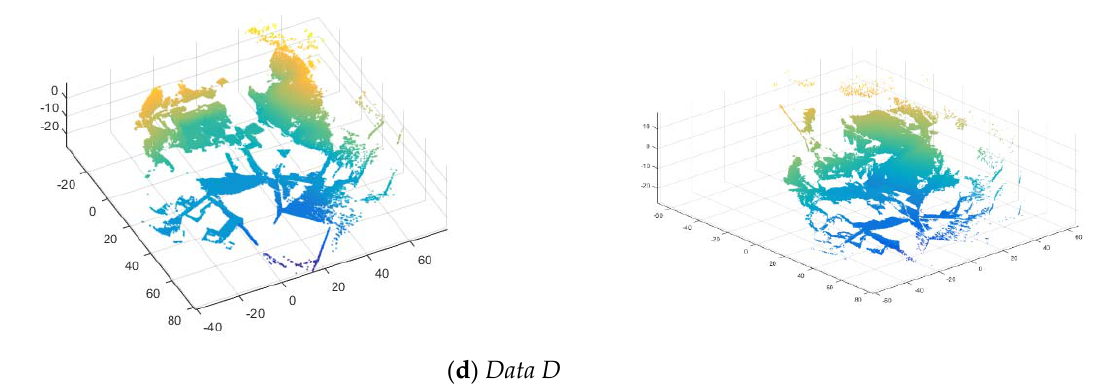
Figure 8. Demonstration of a scan of the data used.